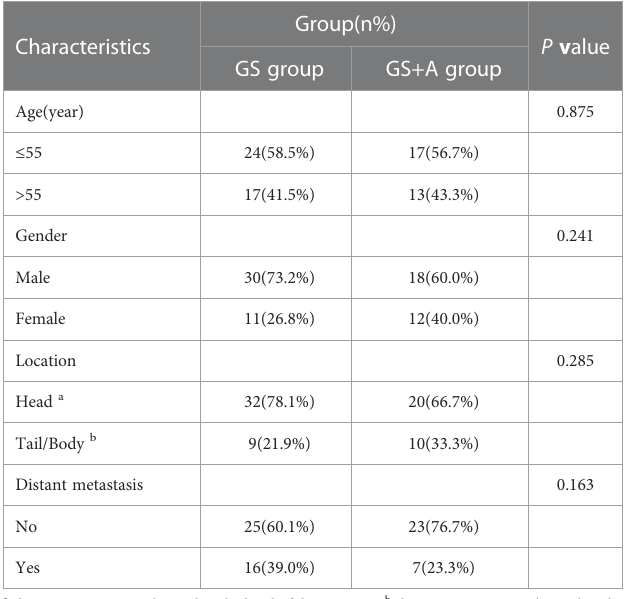
TABLE 1 Clinical parameters of the